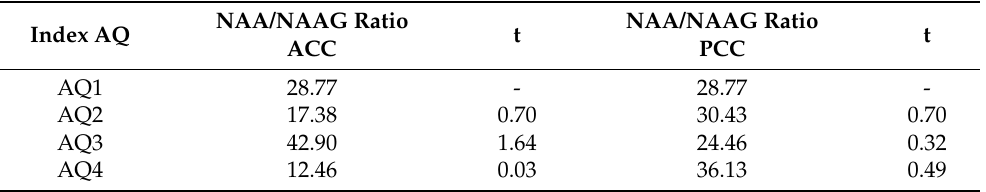
Table 7. Differences in the NAA/NAAG ratios in AQ2, AQ3, and AQ4 with respect to AQ1, evidenc- ing changes in all autism spectrum groups. p < 0.05 =